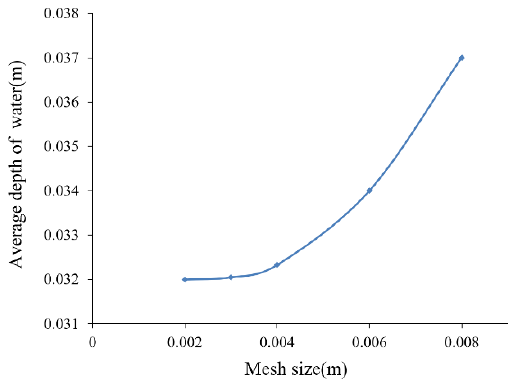
Figure 2. Mesh irrelevance test.